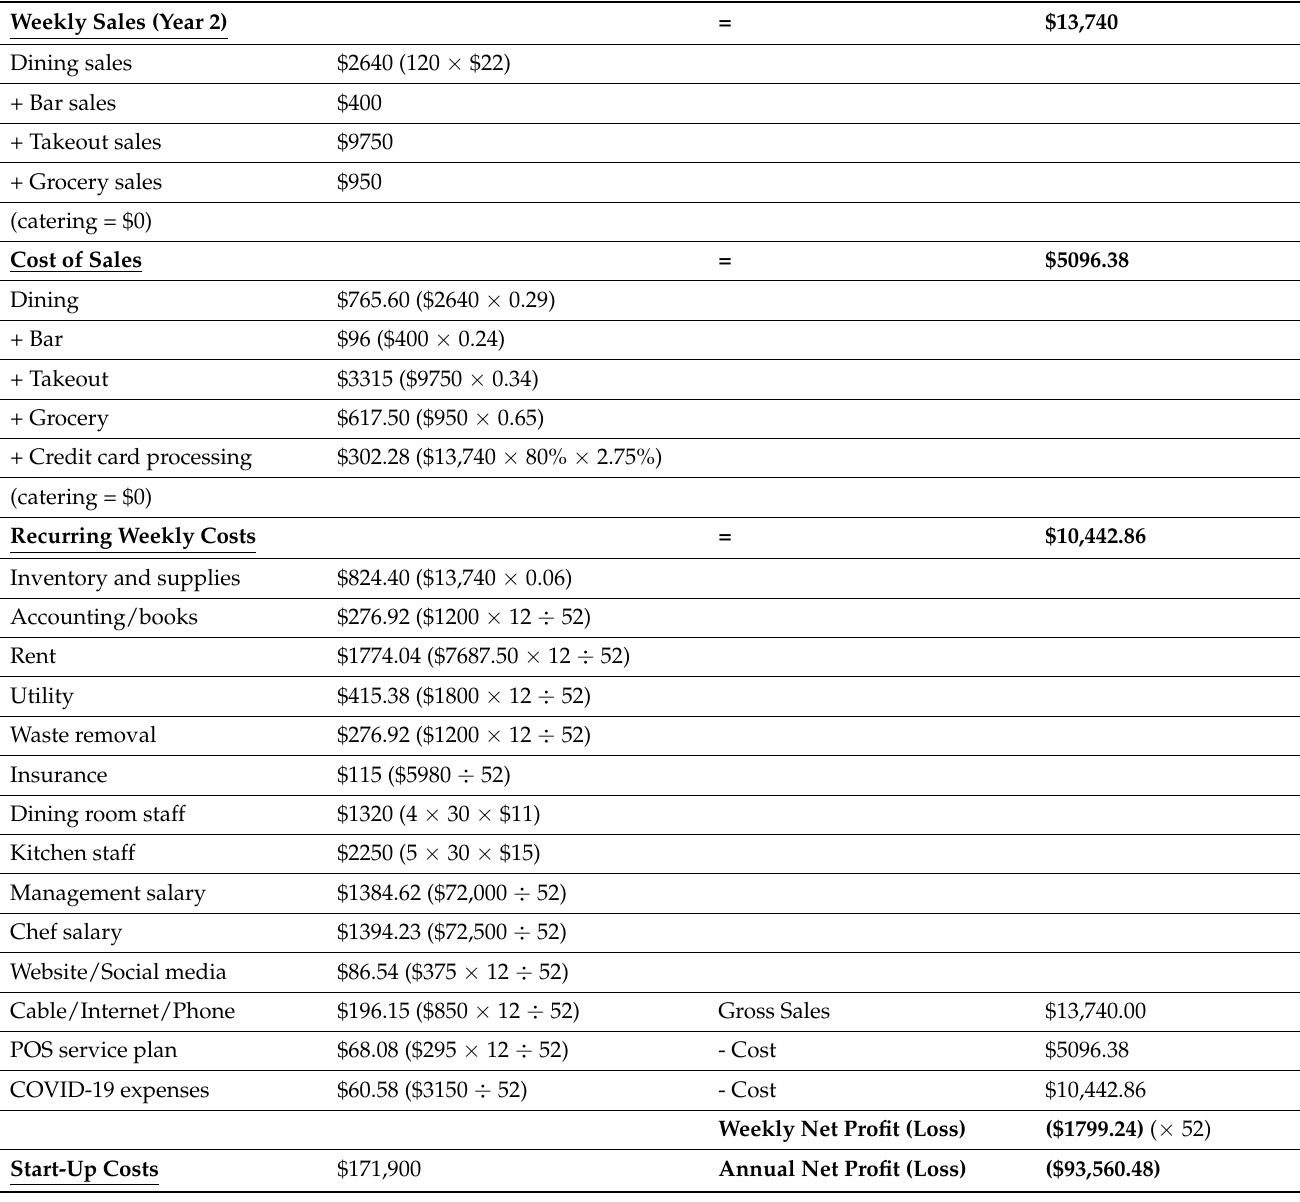
Table 3. Year 2 (during COVID) estimated operating costs. These are a composite of the sales statistics of three actual restaurants located in Long Island, New